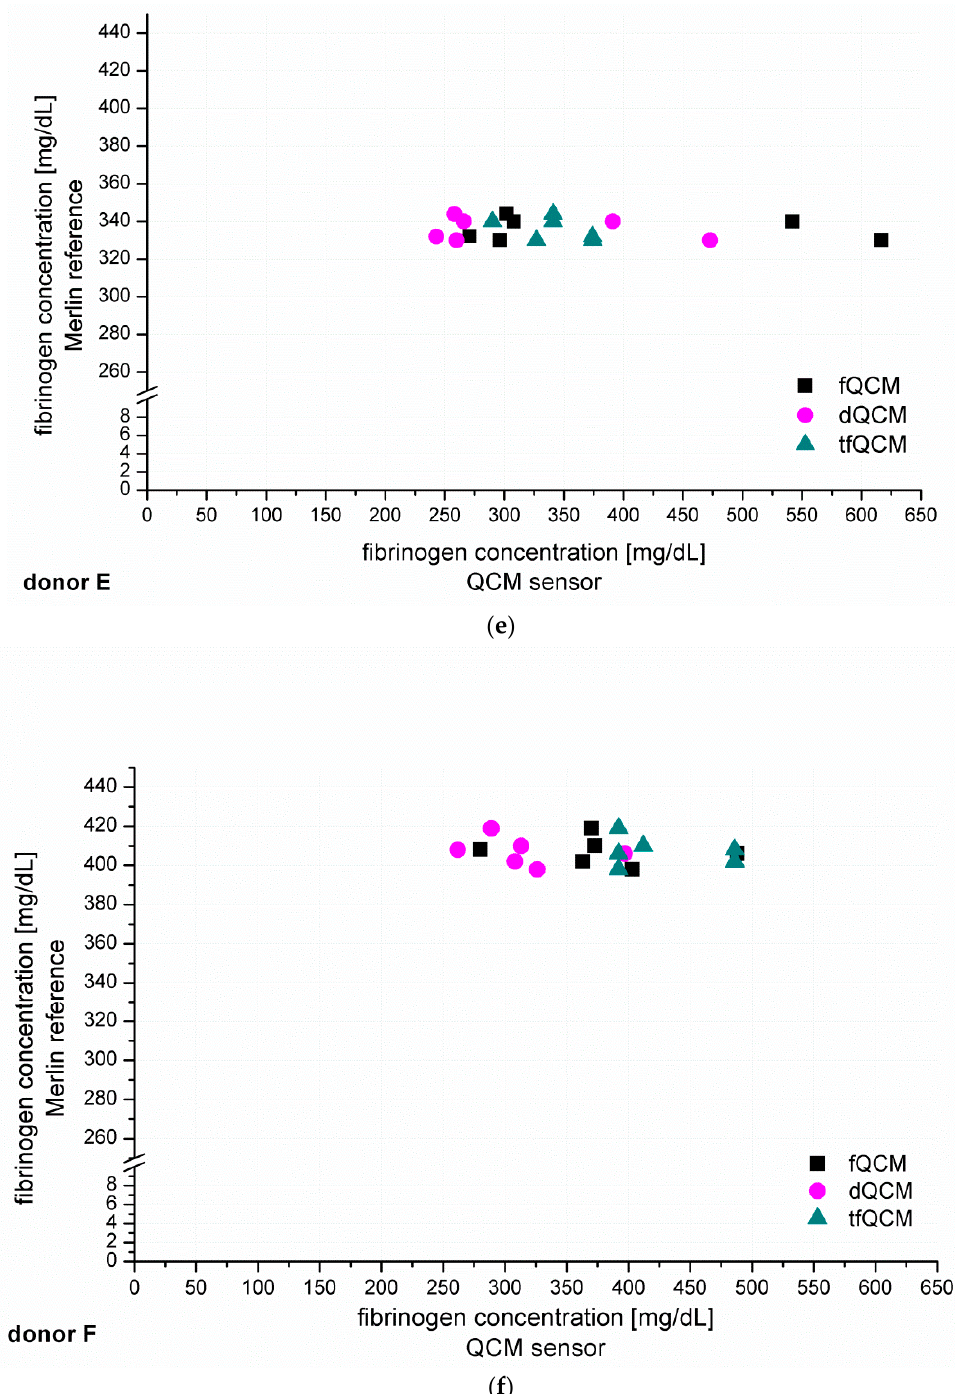
Figure 4. ( a – f ) show the individual results of the QCM-D-based determination of unknown fibrinogen levels conducted for six healthy blood donors (donor A–F). The QCM-D measurements were conducted n = 8 times for donor A–D and n = 6 times for donor E–F. The experiments were conducted with 1:10 diluted plasma and accordingly coated quartzes. The y-coordinate shows the results of the simultaneously conducted internal Merlin reference whereas the x-coordinate shows the QCM-D results in direct comparison.